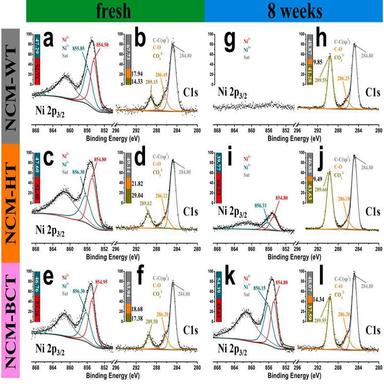
High-resolution XPS spectra of Ni 2p and C 1 s of treated samples before/after storing in ambient air for 8 weeks: (a-b) NCM-WT, (c-d) NCM-HT, (e-f) 8NCM-BCT, (g-h) 8NCM-WT, (i-j) 8NCM-HT, and (k-l) 8NCM-BCT, respectively (Corresponding peak area ratios are on the left).